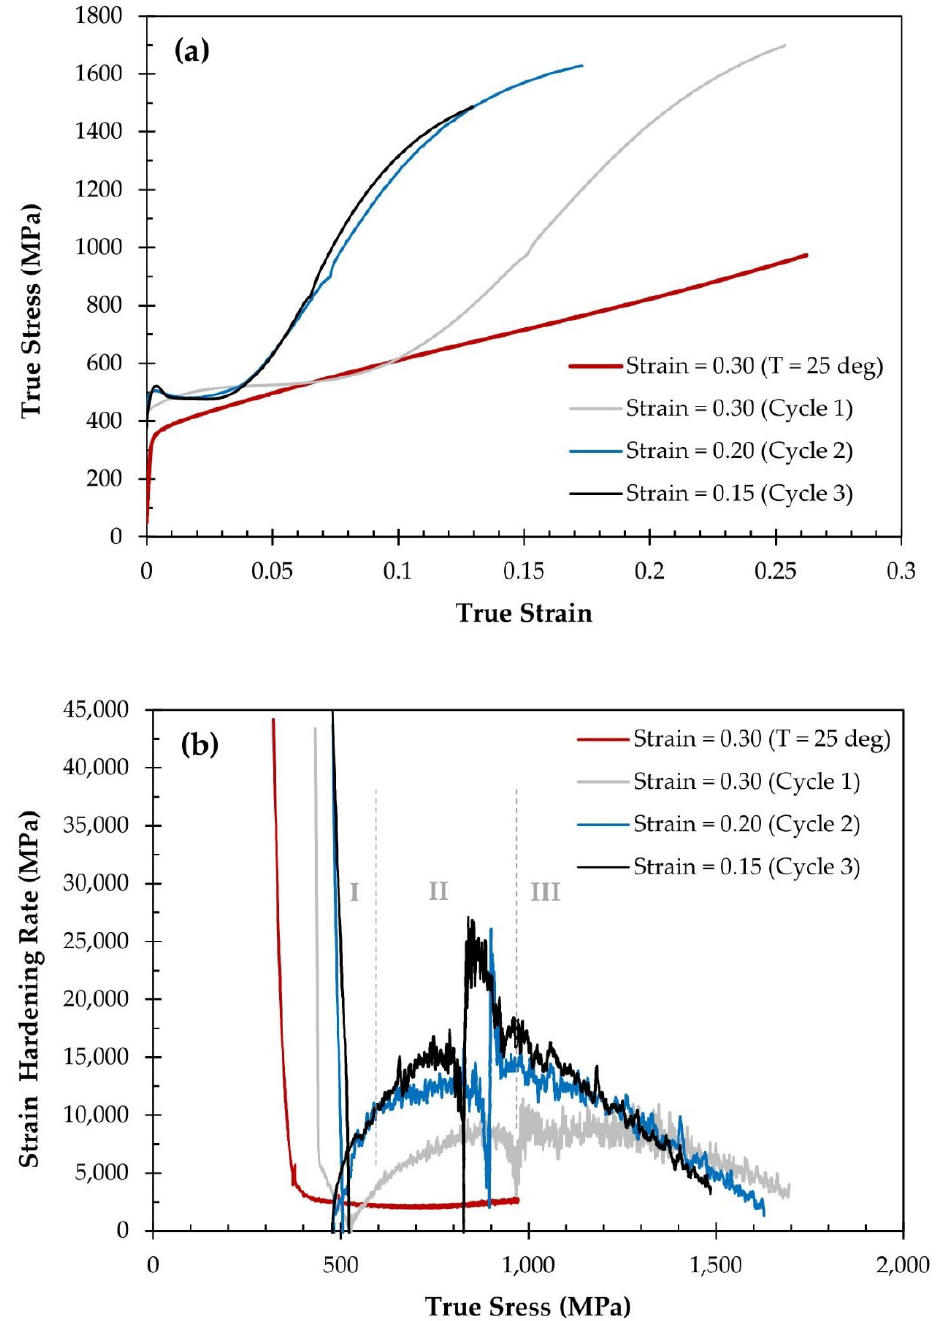
Figure 10. Tensile behavior of TMP samples: ( a ) True stress vs. true strain and ( b ) strain hardening rate (d σ /d ε ) vs. true stress. Three strain hardening stages are illustrated for the sample processed by a strain of 0.30. Table 5. Yield strength of 301 stainless steel samples.